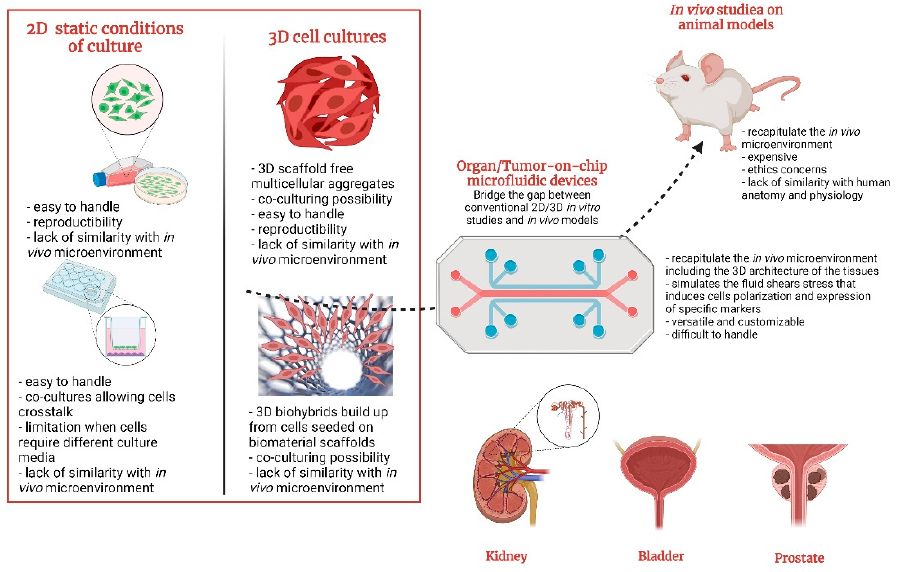
Figure 4. Schematic representation of the available in vitro and in vivo models for the urology- associated pathology study, highlighting their advantages and disadvantages and revealing the potential key role of the organ/tumor-on-chip devices to bridge the gap between conventional 2D/3D culture systems and animal models in preclinical studies.